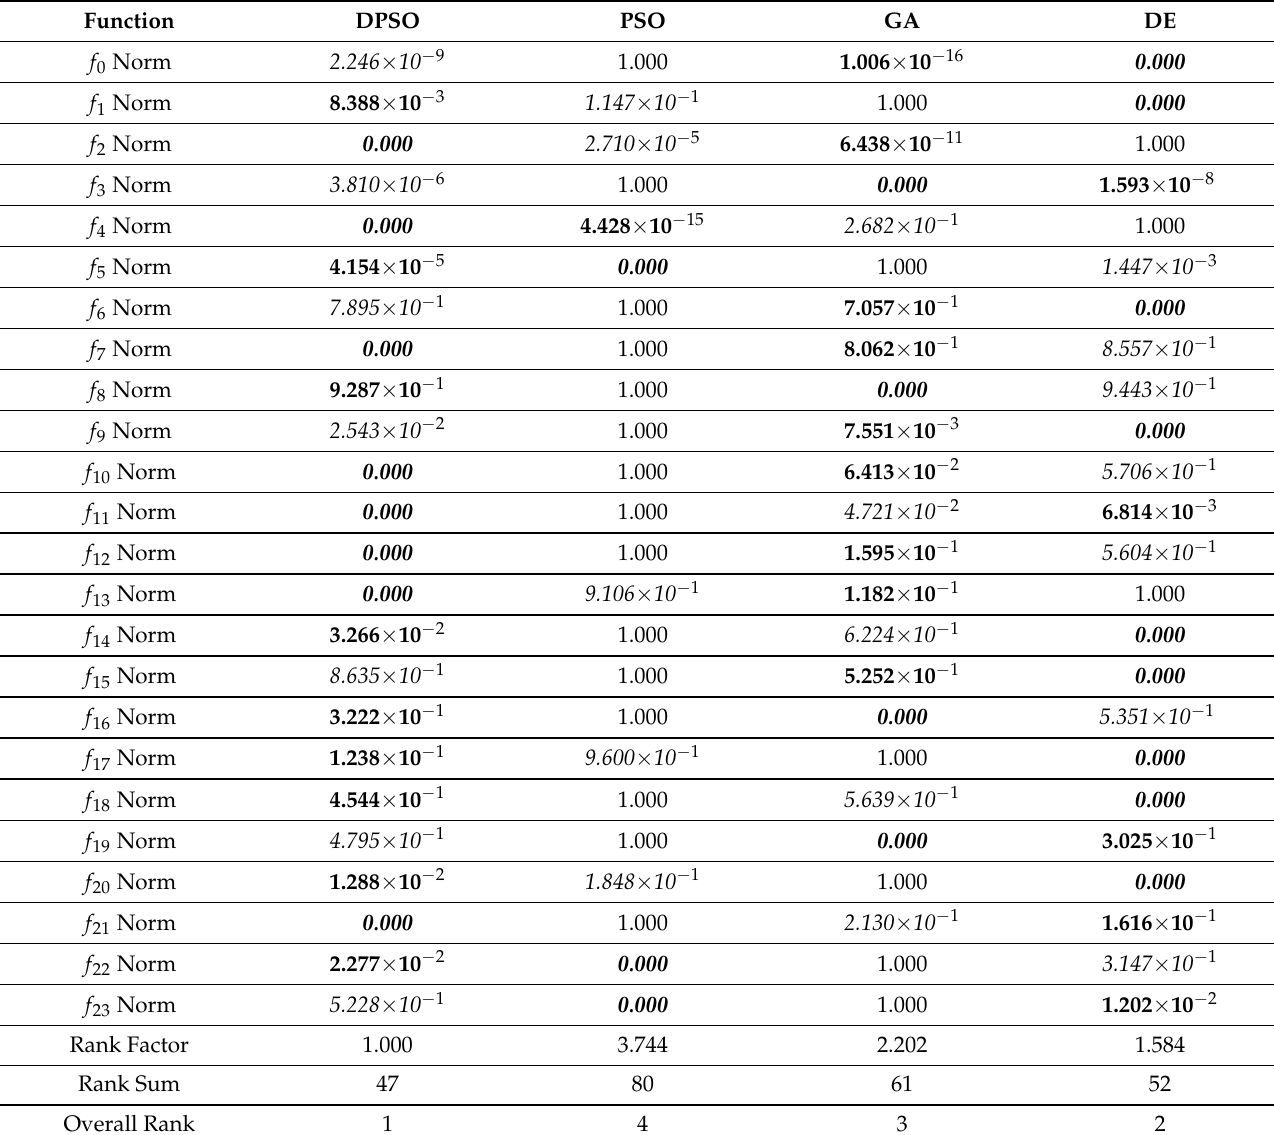
Table 4. Normalized fitness w.r.t. each function problem with 21 dimensions and the resulting ranking: rank 1 (best) , rank 2 , rank 3 , and rank